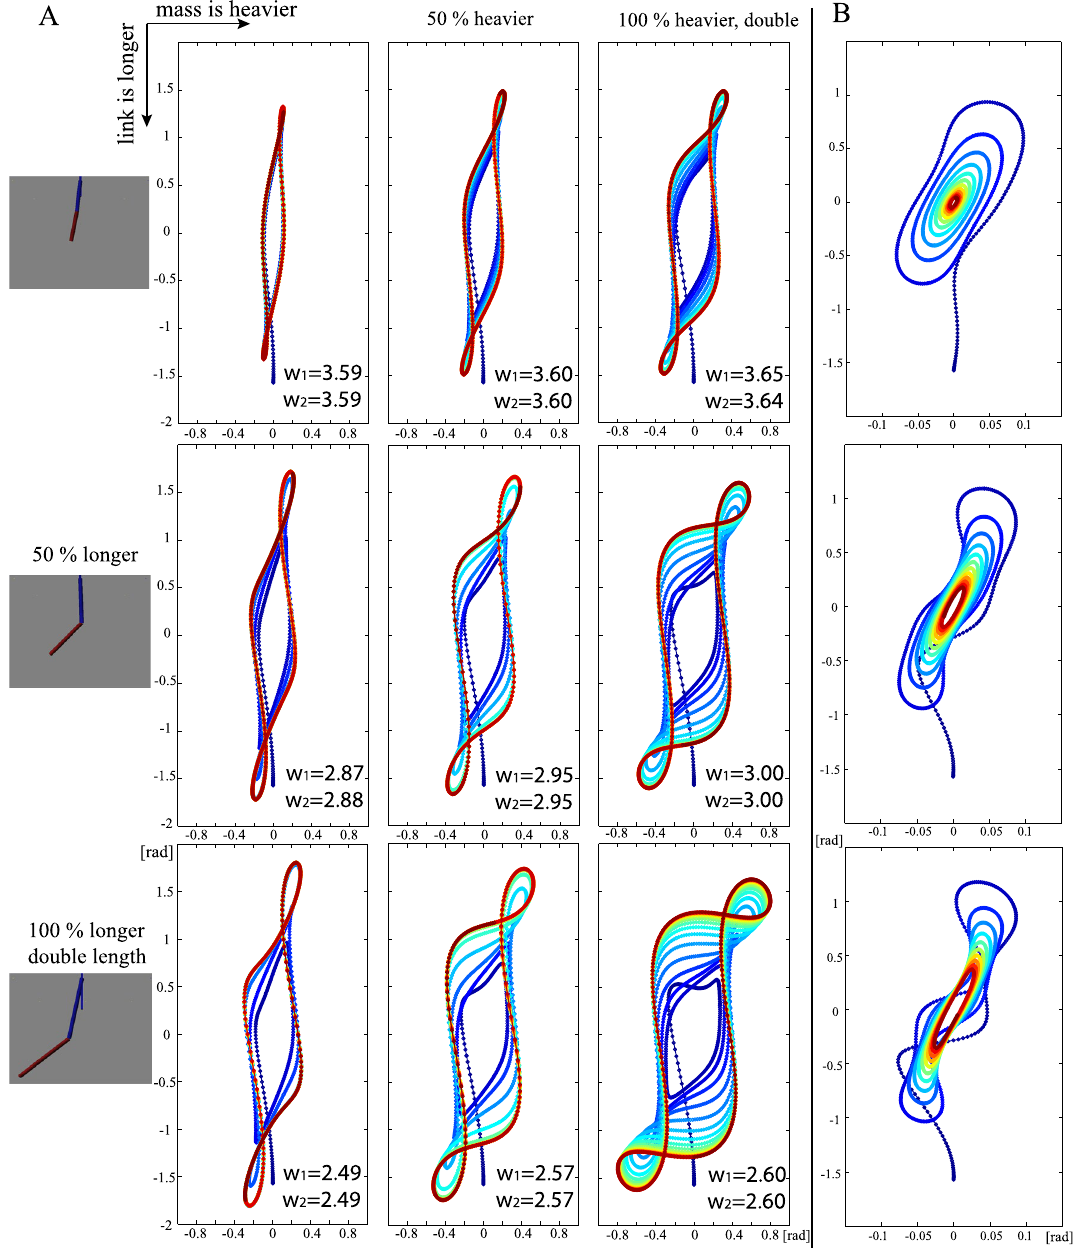
Figure 1. ( A ) Phase portrait of a double pendulum controlled with the proposed neural integrator in different dynamic conditions. The pendulum length and mass were changed. The dynamics setting was set blind for the controller. The first joint angle in the x-direction and the second joint angle in the y-direction. Even under different physical conditions, limit-cycle oscillations could be created, without the so-called coupled oscillator model. The converged oscillation frequency was different for different conditions. The long limb case resulted in a slow oscillation and the short limb resulted in a fast oscillation. ( B ) shows the results when the integration term was omitted for the original mass condition. From top to bottom, the length of the limb increases, which is similar to the condition on the left-hand side. Without the integration term, the energy was dissipated by damping and the oscillation could not be sustained. We find a “frequency modulation” function that corresponds to different dynamic conditions. Movie S1 shows the simulation results for this